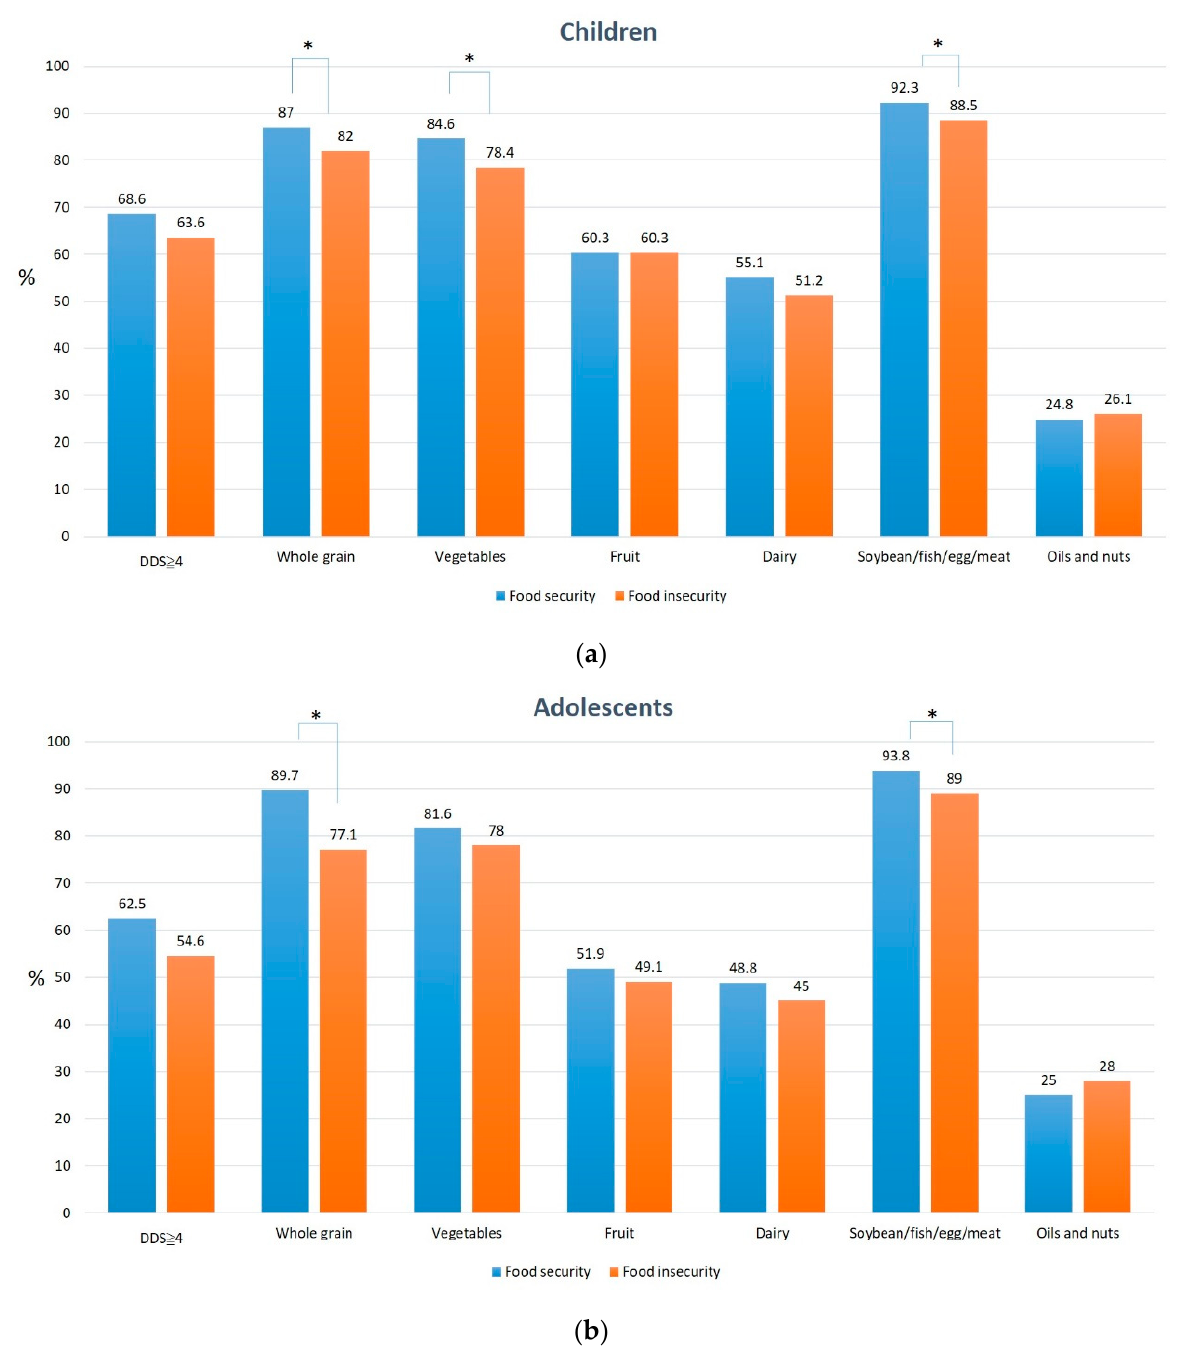
Figure 1. Dietary diversity score and its components and food security among children ( a ) and adolescents ( b ). * p < 0.05.